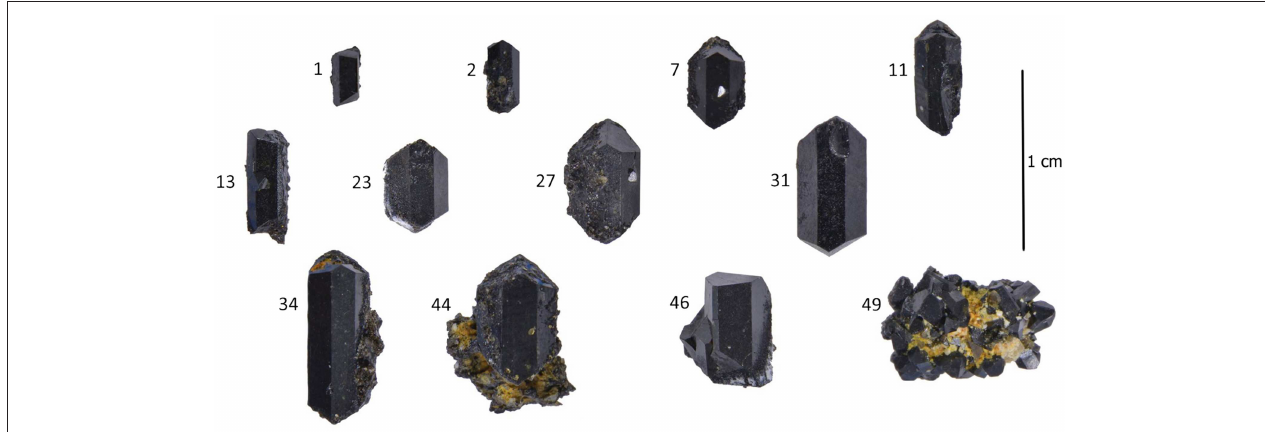
FIGURE 2 | Selection of 12 clinopyroxene megacrysts analysed in this study. The crystals are perfectly euhedral augites, oriented with their c crystallographic axis in vertical position (following the scale bar). Crystals 2, 7, 11, 23, 27, 31, 34, and 44 are laying on {100}, whereas 1, 13, and 46 are slightly rotated around the c -axis showing {110} in the foreground. Samples 11 and 13 are swallow-tail crystals twinned on {100}. Often, crystals have inclusions of olivine on the surface, remnant inclusion indentations (e.g., 31), and/or are coated with glassy matrix (e.g., 34). Sample 49 is a complex